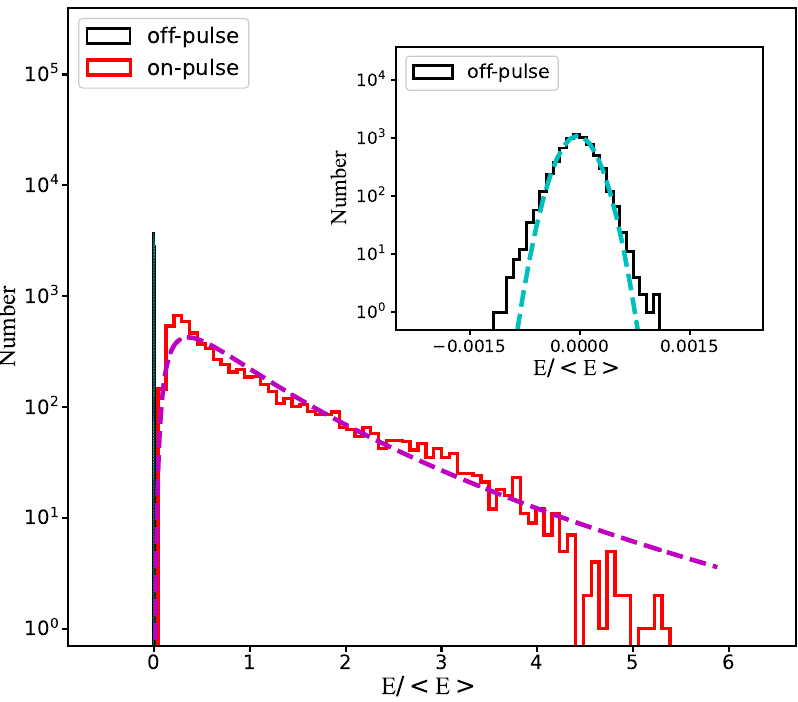
Figure 4. The relative energy distribution histogram of PSR B0950+08. The solid red and black lines represent the on-pulse and off-pulse regions, respectively. The energy of each single pulse was normalized by the average pulse energy. The magenta dashed line is a log-normal distribution fitted to the relative energy of all the pulses. The cyan dotted line in the insert panel is the off- pulse